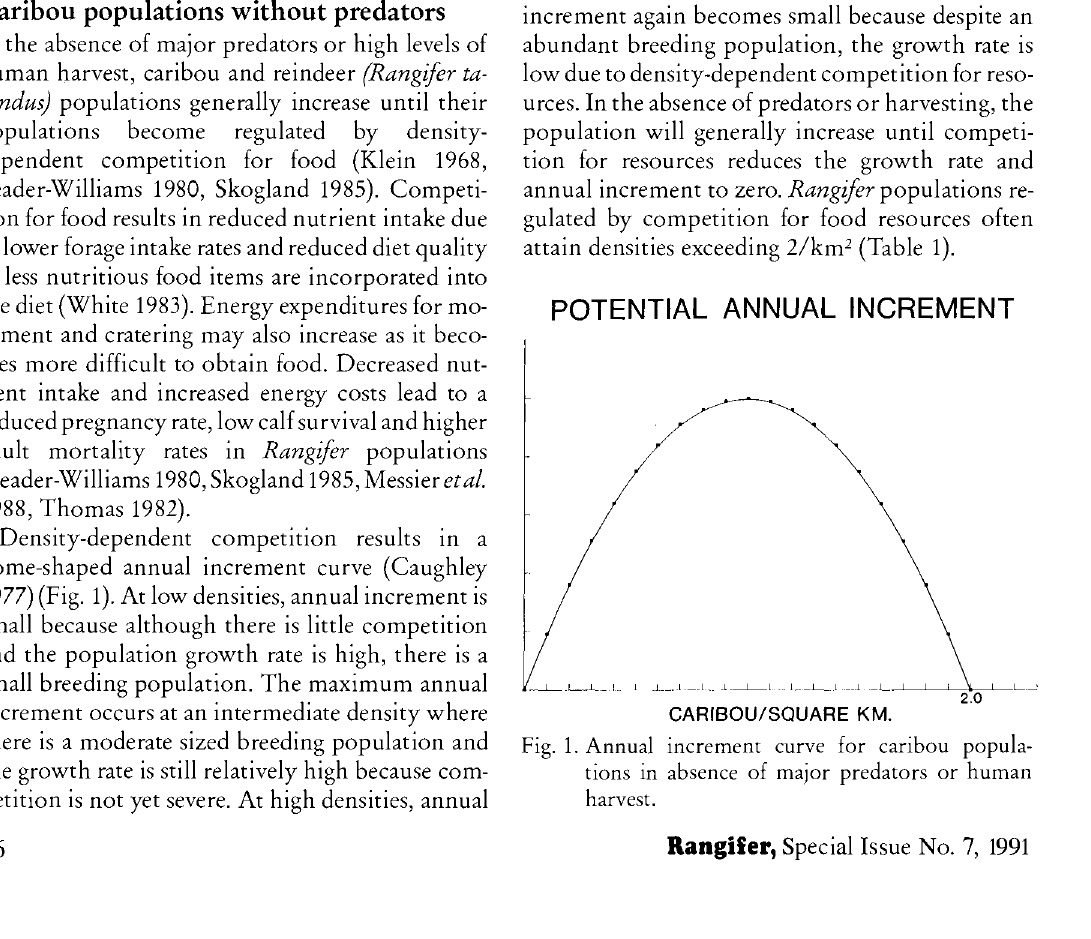
Fig. 1. Annual increment curve for caribou popula tions in absence of major predators or human